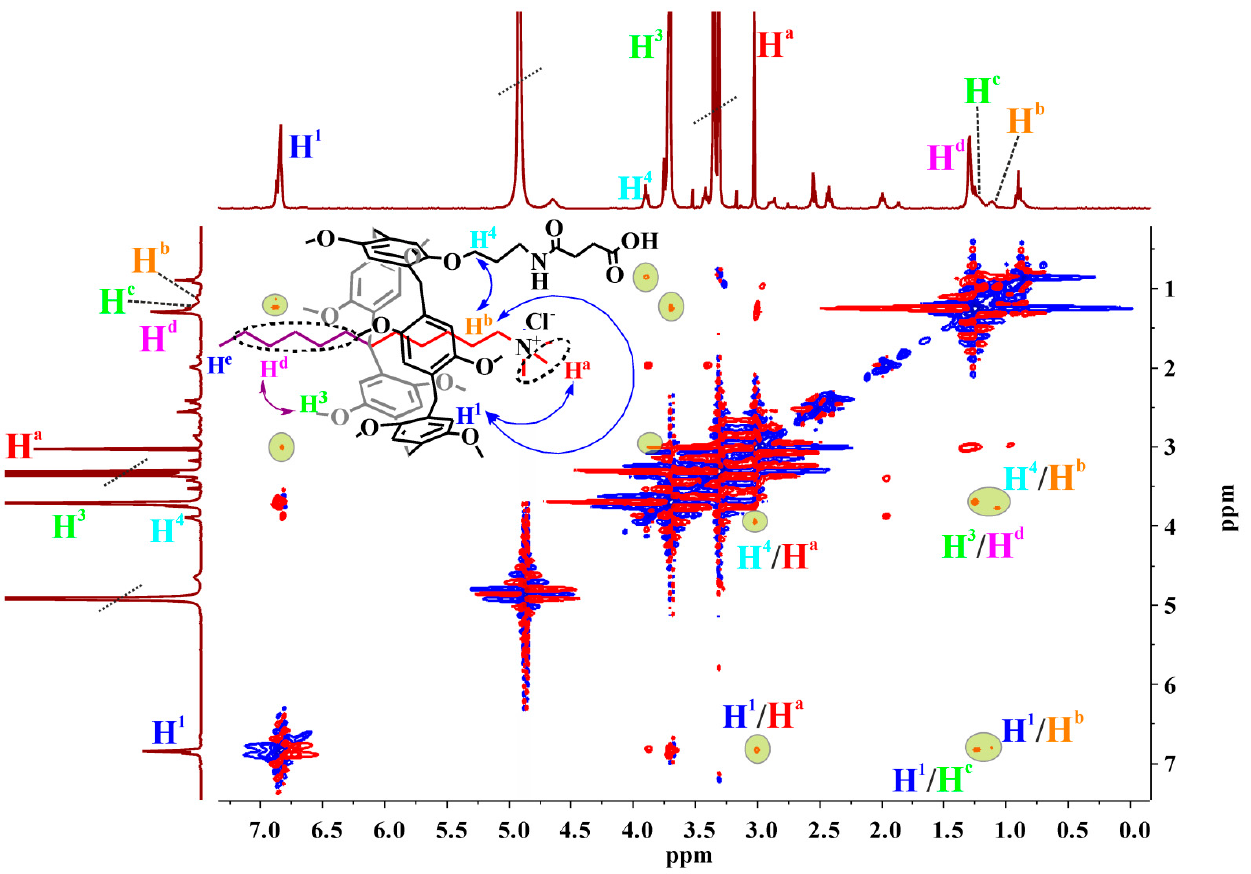
Figure 4. 1 H- 1 H NOESY NMR spectrum of compound 4 with DTAC (ratio 1:1) (in MeOD- d 4 , 298 K, 400 MHz).